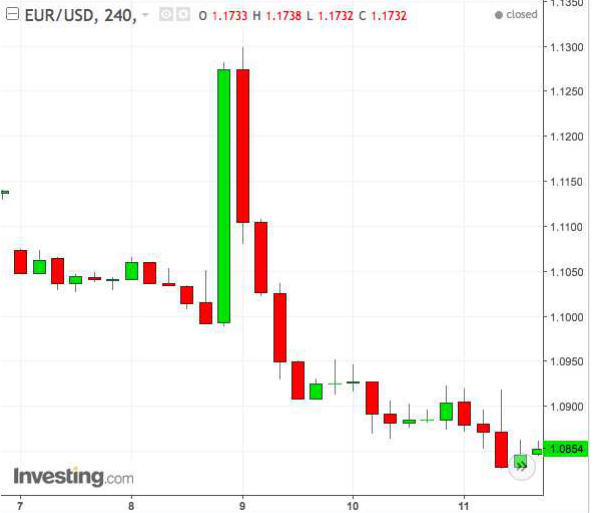
Figure 3. The EUR/USD pair rate jump on the day of the US presidential election (November 8, 2016)